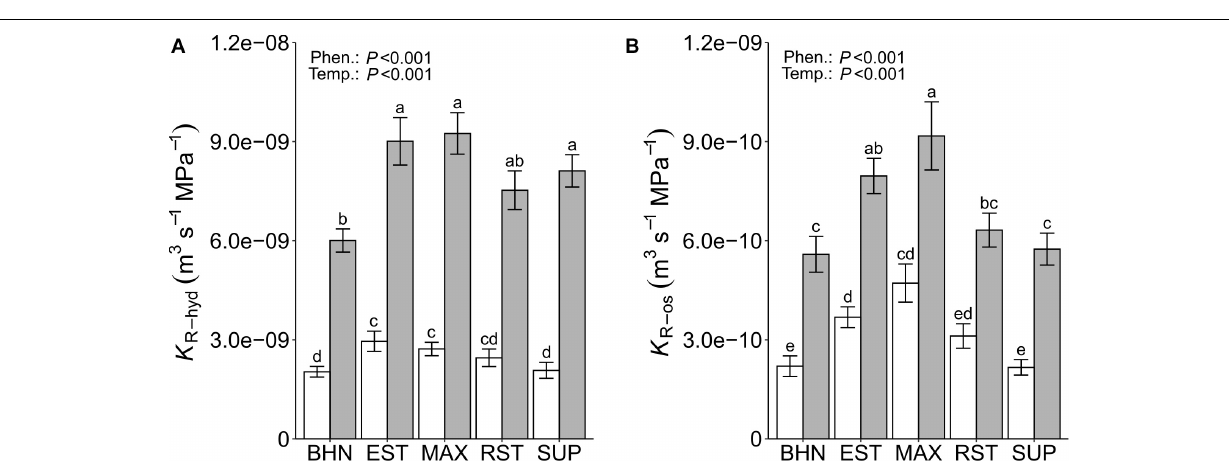
FIGURE 2 | Root hydrostatic ( K R − hyd ; A ) and osmotic ( K R − os ; B ) hydraulic conductance on whole-root systems of four grafted rootstocks (Estamino, Maxifort, RST-04-106-T, and Supernatural) and one cultivar (BHN-589) grown under optimal (gray) and suboptimal (white) soil temperatures for 4 weeks. All rootstocks were grafted with BHN-589. Values are mean ± standard error ( A: n = 28–34; B: n = 24–29). Means followed by different letters are statistically different at P <